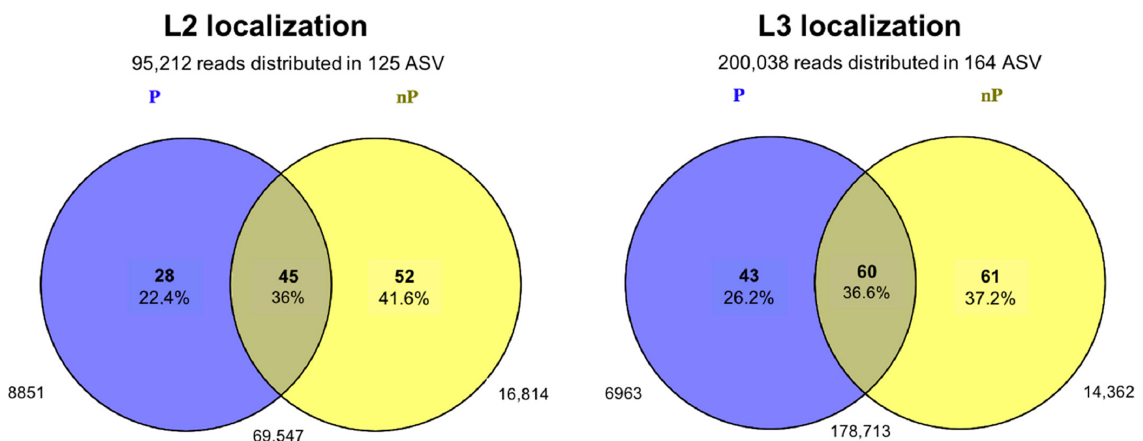
Figure 4. Venn diagrams showing the overlap of the AMF communities across P and nP sites, considering the entire mining area (A) or each localization individually (L1 localization, L2, and L3). Shared and specific ASV numbers and their relative abundance (in percent) are given inside the circles; the read numbers are given out of the circles. Considering each localization, the same trend was observed, with P sites showing a lower number of specific ASVs compared to non-P sites. The most contrasting difference was observed in location two, where the number of nP-specific ASVs was almost twice the amount of P-specific ASVs (52 ASVs, or 41.6%, versus 28 ASVs, or 22.4%, respectively) (Figure 4). Variations in ASVs abundance among P vs. nP sites were also observed, as depicted in Figure 5, focusing on the 50 most abundant ASVs. In addition, it highlights the higher abundance of ASV 61, 62, and 208 in all sites.